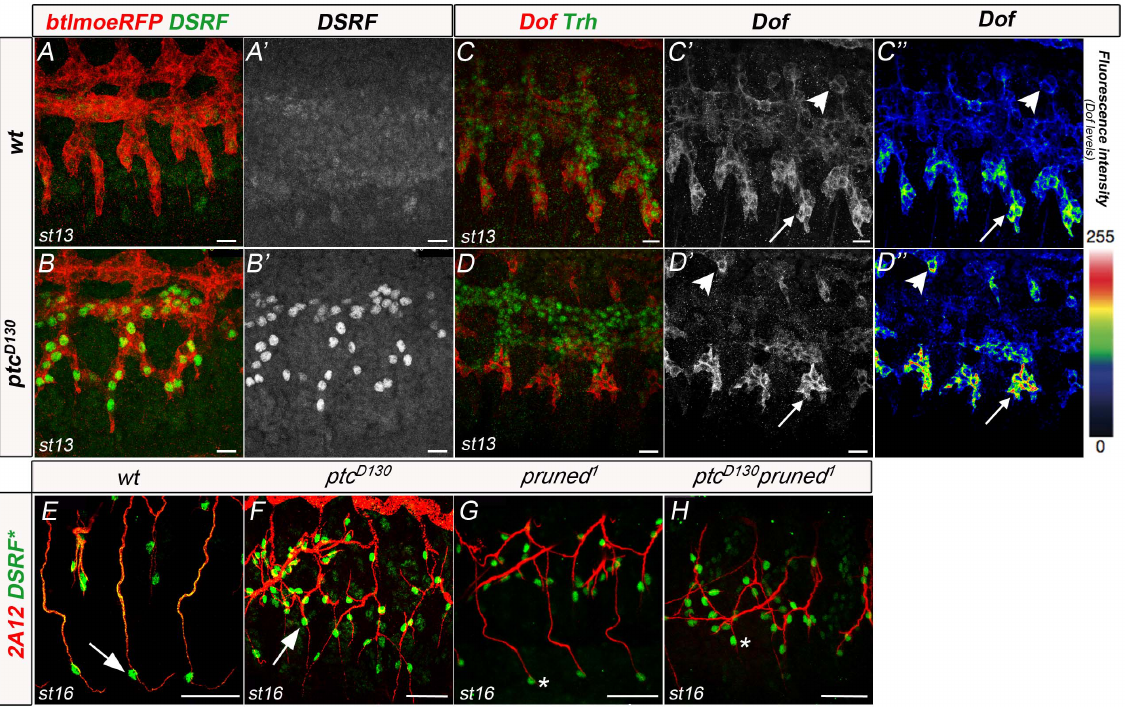
Figure 4. ptc mutants start expressing DSRF earlier. (A,B) Stage 13 wt (A, A 9 ) and ptc mutant (B, B 9 ) embryos carrying the btlmoeRFP reporter stained with anti-RFP to visualise the tracheal cells and anti-DSRF antibody to mark all terminal-cell nuclei. ptc embryos start expressing DSRF earlier than the wt. Scale bars are 10 m m. (C,D) Late stage 13 wt (C, C 9 ) and ptc mutant (D, D 9 ) embryos stained with anti-Dof and anti-trh antibody. All ptc embryos analysed have higher levels of Dof in DB tip-cells (arrowheads in D 9 and D 0 , n=12). Scale bars are 10 m m. (E,F) Detail of stage 16 GBs stained with 2A12 and anti-DSRF in wt (E) and ptc embryos (F). (G,H) Detail of stage 16 GBs from embryos carrying the pruned-lacZ reporter stained with 2A12 and anti-ßgal in pruned (DSRF) mutant (G) and double ptc pruned mutant. Terminal cells in pruned mutants do not extend their terminal lumen in wt or ptc mutant backgrounds (asterisks). Scale bars are 25 m m. DSRF* means that in panels E, F the presence of this protein is detected by the antibody, whereas in panels G,H terminal cells are marked by b gal expression. Anterior is left in all